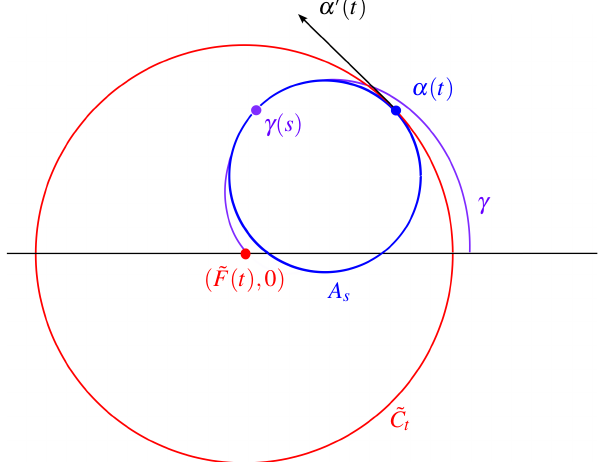
Figure 4: The osculating circle A s at a point on γ and the canonical circle ˜ C t at a point on A